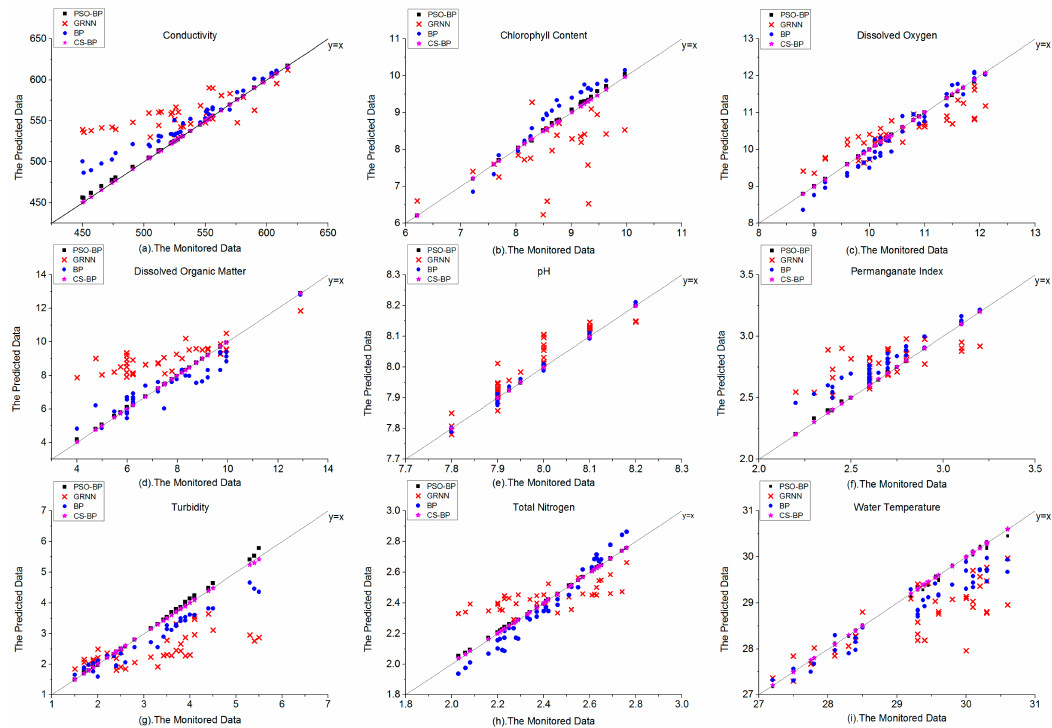
Figure 6. The comparison of predicted data and monitored data of water quality indicators of four models in Scenario